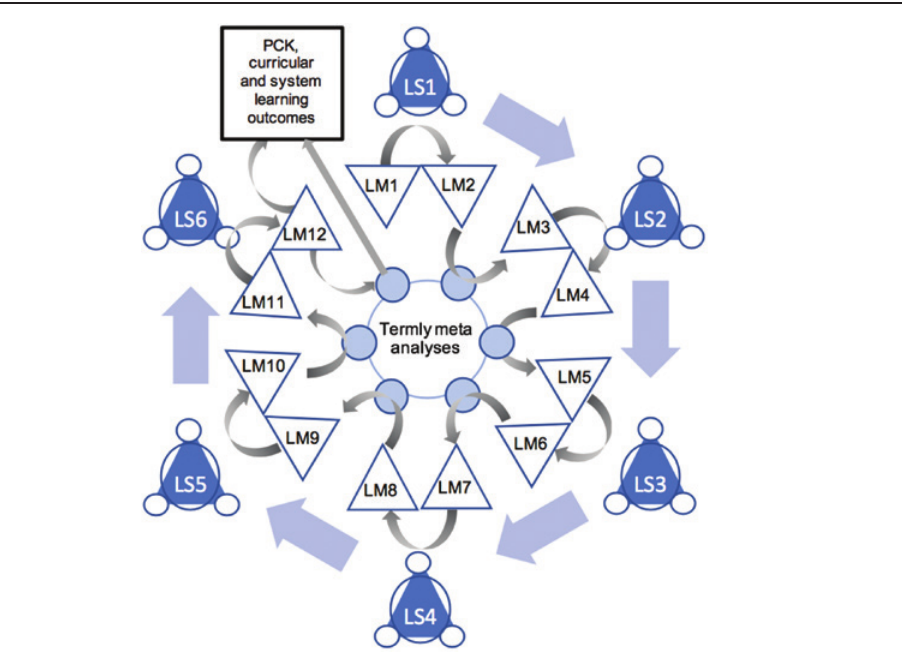
Figure 1: The two-year cycle of twice termly local meetings for curriculum study and sharing lesson study findings (LM), school-based lesson studies (LS) and termly